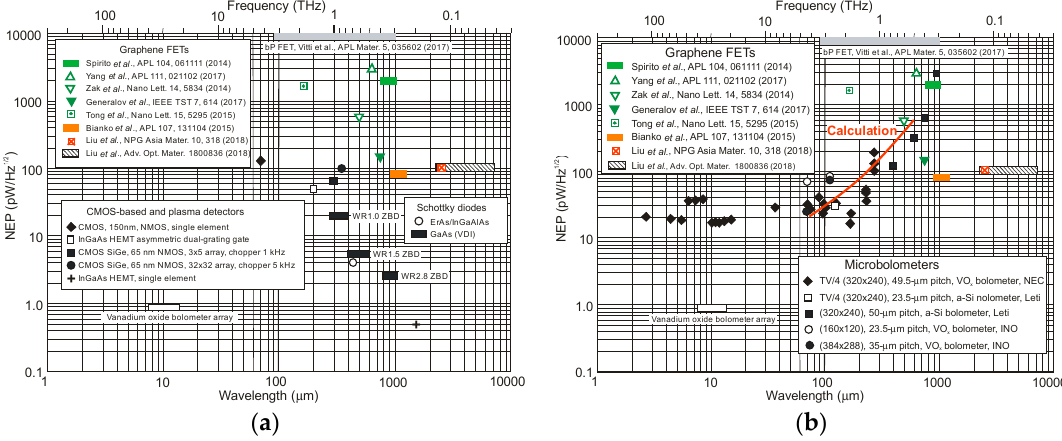
Figure 3. NEP spectral dependence for graphene FET detectors and different terahertz photon (CMOS-based, Schottky diodes) ( a ) and microbolometers ( b )